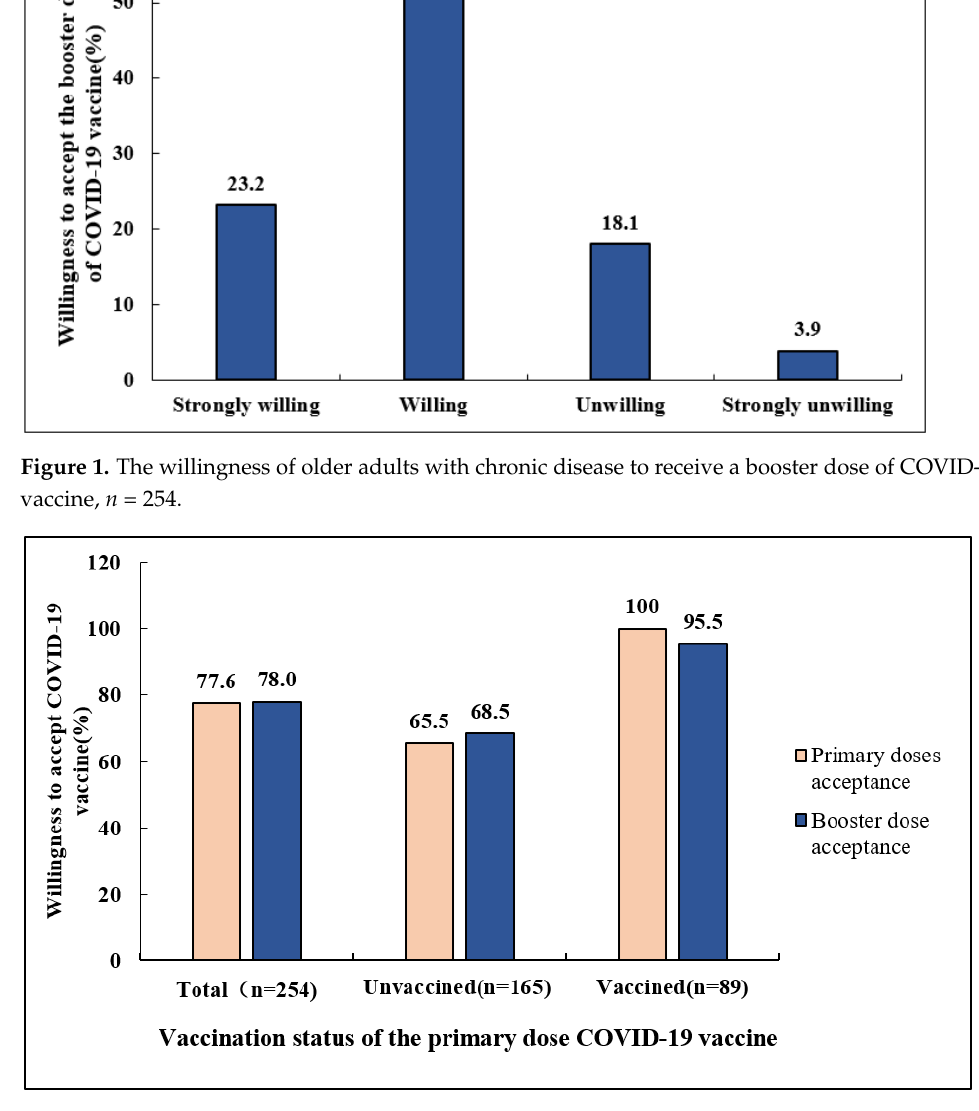
Figure 2. Willingness to accept COVID-19 vaccine in vaccinated and unvaccinated participants, n = 254.